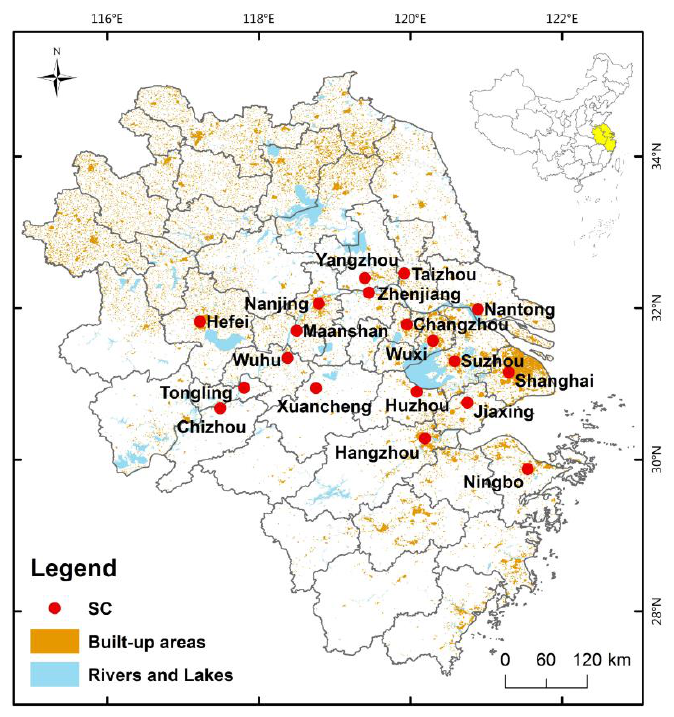
Figure 1. The location of Yangtze River Delta (YRD) and YRD cities (SC).